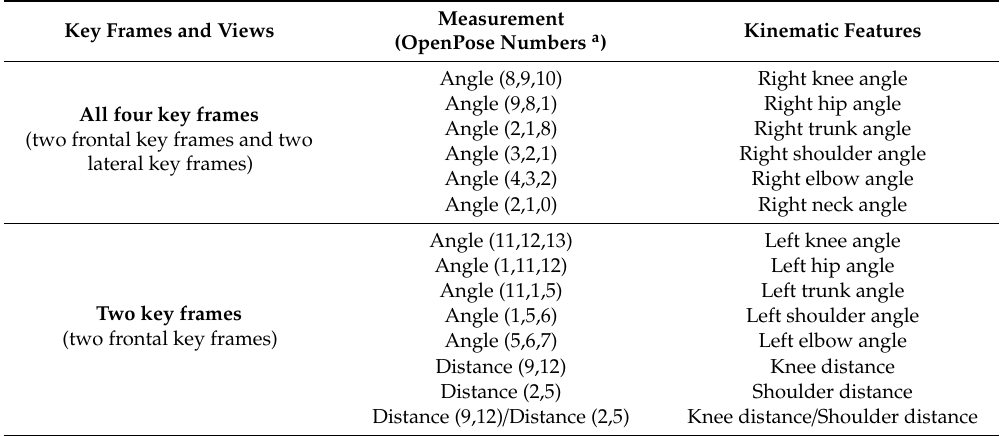
Table 3. Measurements extracted from key frames and used as kinematic